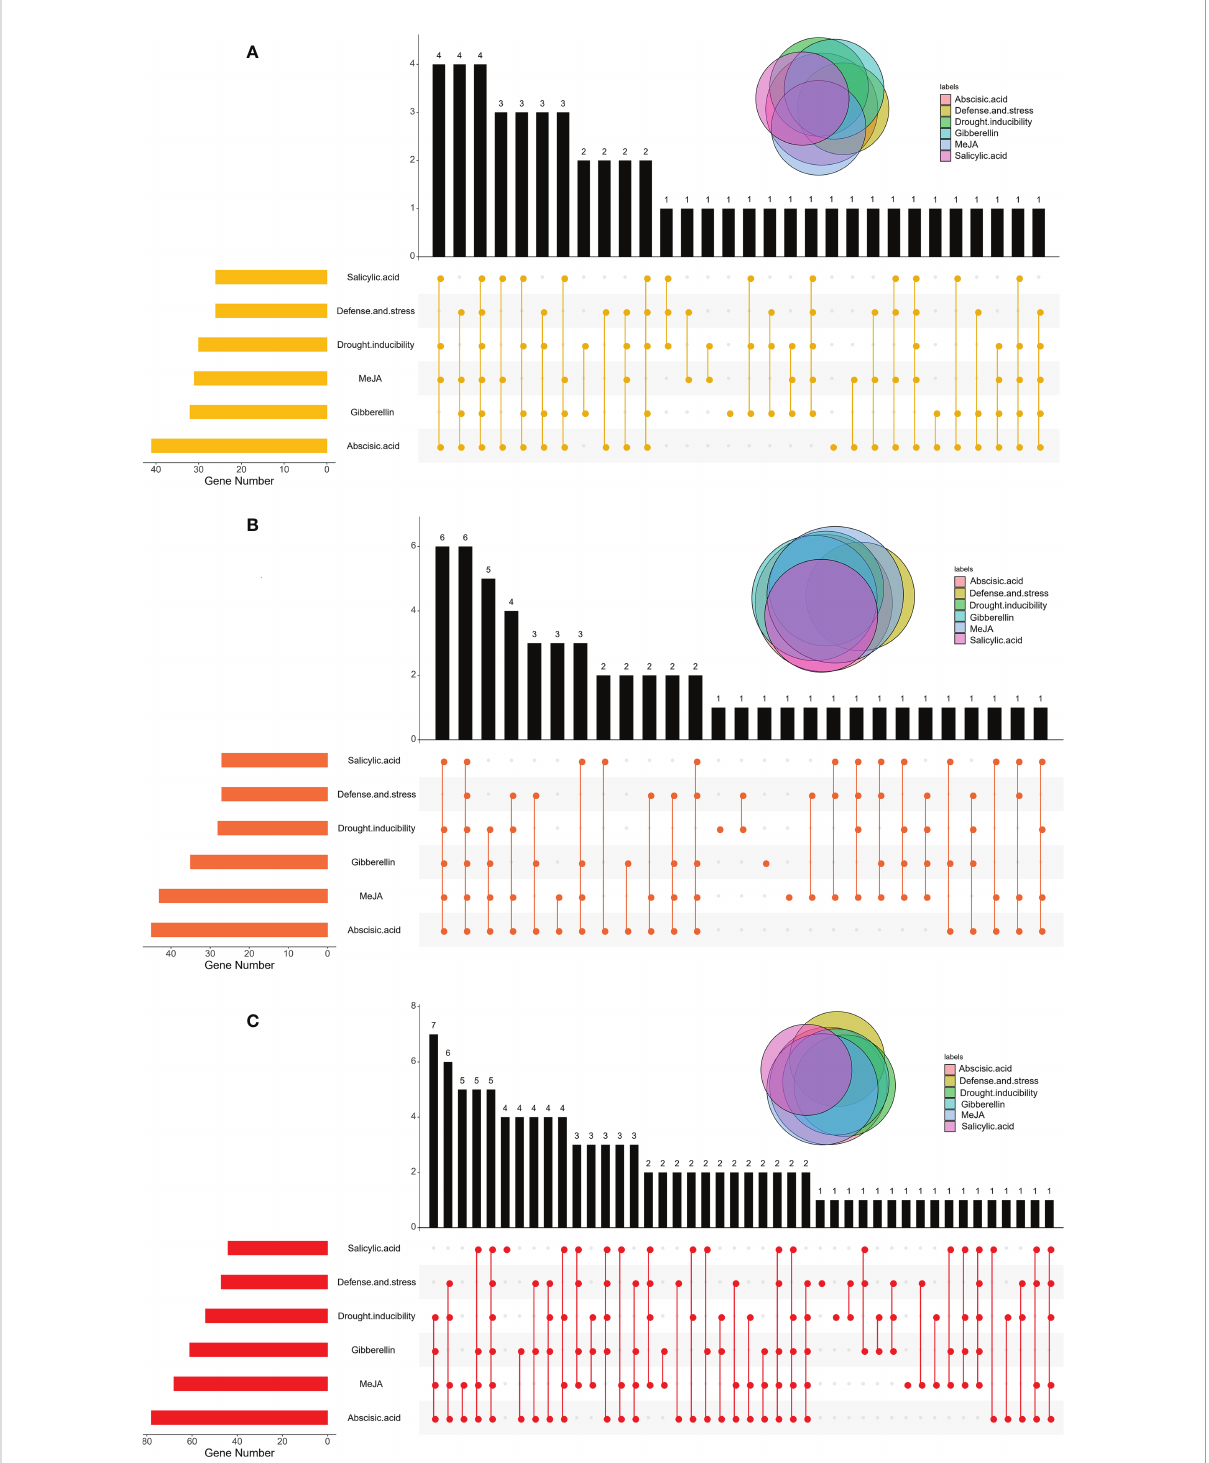
FIGURE 5 Distributions of cis-acting elements in BraCPKs (A) , BolCPKs (B) , and BnaCPKs (C) promoter. The Upset plot shows the distribution of cis-acting elements in CPKs promoter. The bar chart above represents the number of genes contained in each type of CPK. The bar chart at the bottom left represents the number of genes included in each type of cis-acting element. The dotted line shows the types of cis-acting elements contained in the